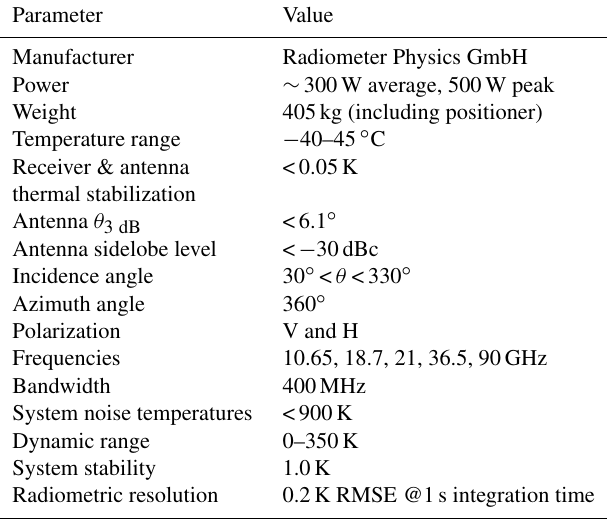
Table 2. SodRad technical